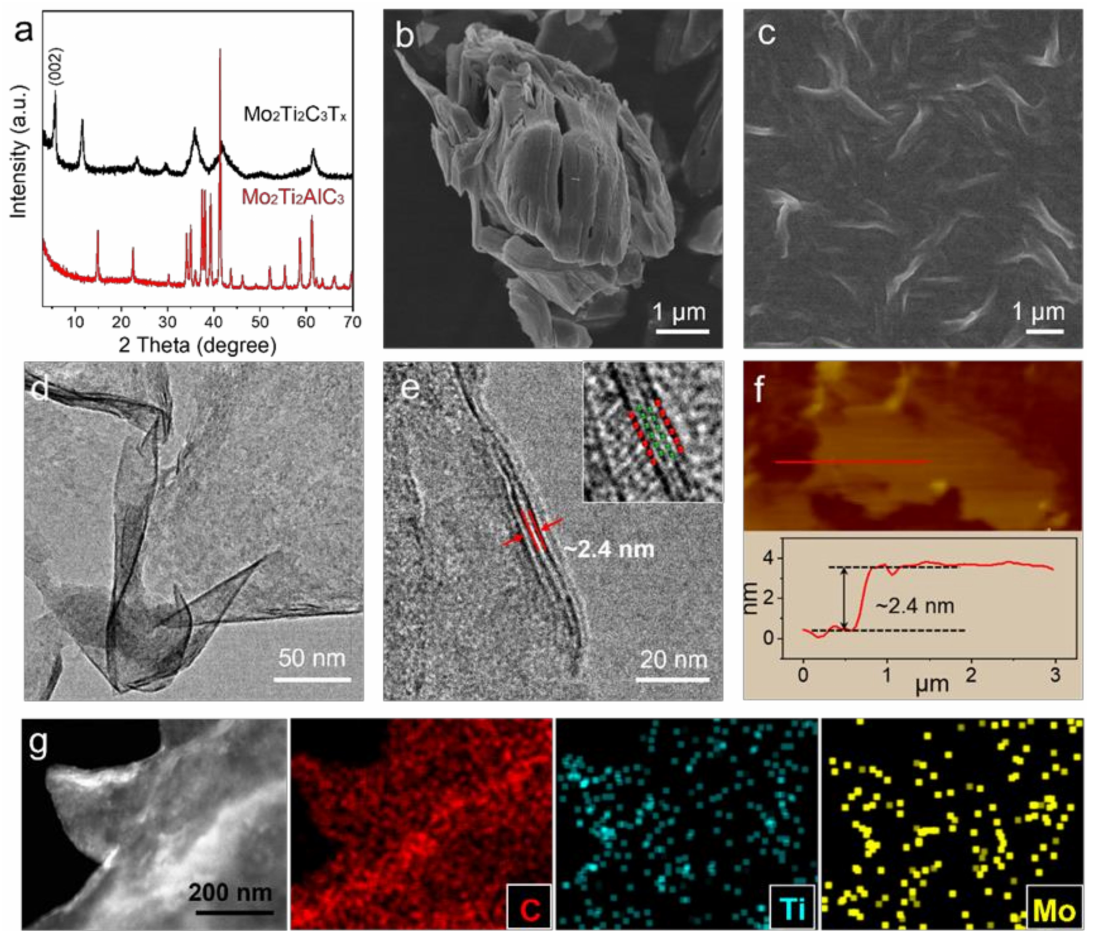
Figure 1. ( a ) XRD patterns of the Mo 2 Ti 2 AlC 3 precursor and Mo 2 Ti 2 C 3 T x MXene materials. SEM images of ( b ) etched multilayer and ( c ) exfoliated few-layer Mo 2 Ti 2 C 3 T x nanosheets. ( d ) TEM and ( e ) HRTEM images of the few-layer Mo 2 Ti 2 C 3 T x nanosheets. ( f ) AFM image of the Mo 2 Ti 2 C 3 T x nanosheets and the corresponding height profile. ( g ) STEM image and EDS mapping results of the C, Ti, and Mo